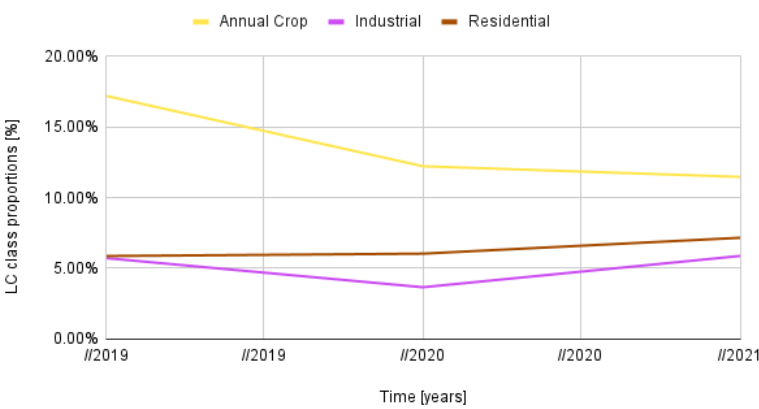
Figure 15. Annual aggregates of LC classes for the observed CER region in Central China, from 2019 to